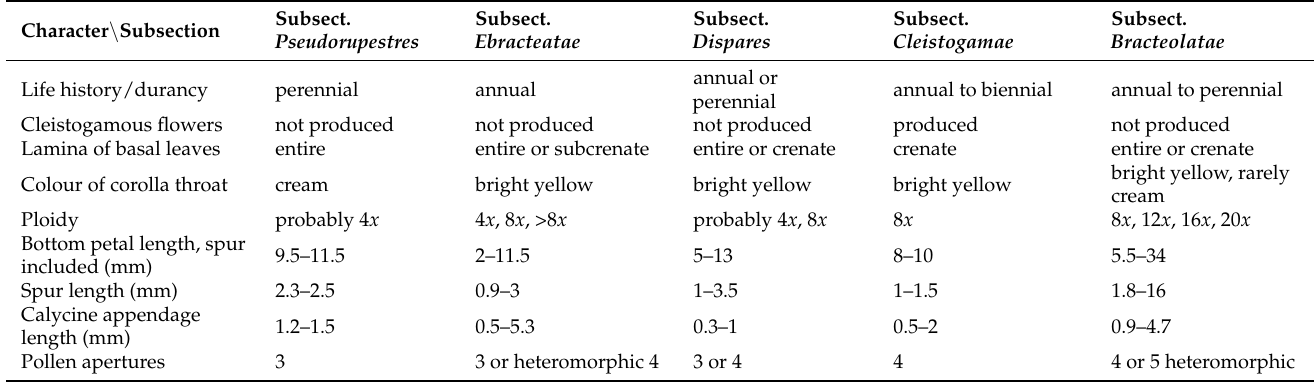
Table 3. Taxonomic characters delimiting subsections within Viola sect. Melanium